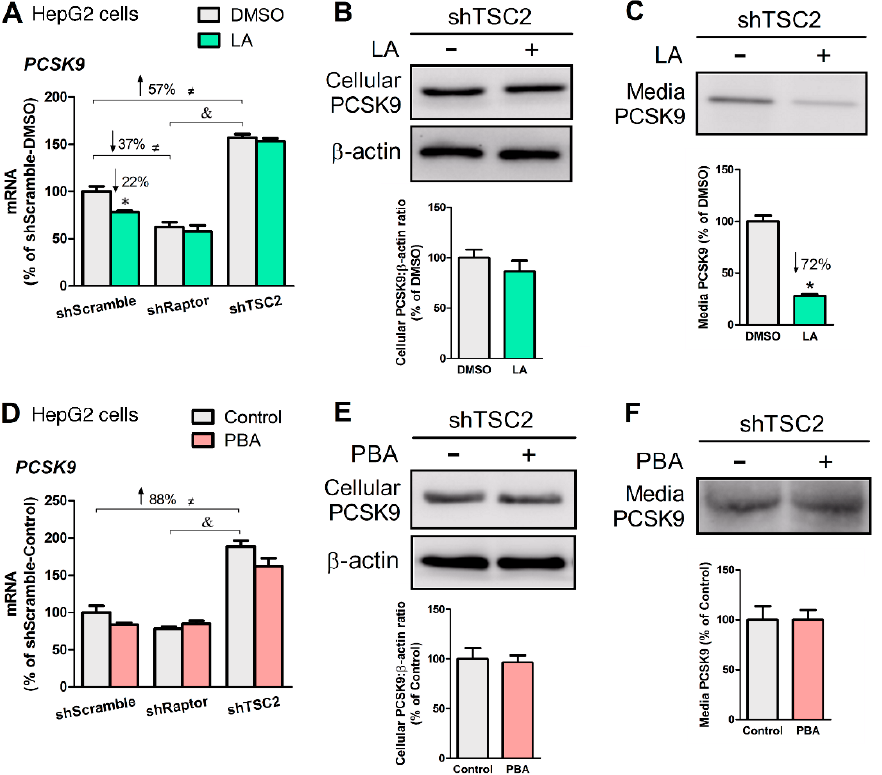
Figure 5. LA, but not PBA, repressed PCSK9 secretion. ( A ) PCSK9 mRNA levels as a ff ected by LA (200 µ M, 24 h) in mTORC1-manipulated HepG2 cells. Cellular ( B ) and media ( C ) PCSK9 protein abundance from HepG2-shTSC2 treated +/ − LA. ( D ) PCSK9 mRNA levels as a ff ected by PBA (8 mM, 6 h) in mTORC1-manipulated HepG2 cells. Cellular ( E ) and media ( F ) PCSK9 protein abundance in HepG2-shTSC2 treated +/ − PBA. * indicates a statistically significant e ff ect of LA vs. vehicle